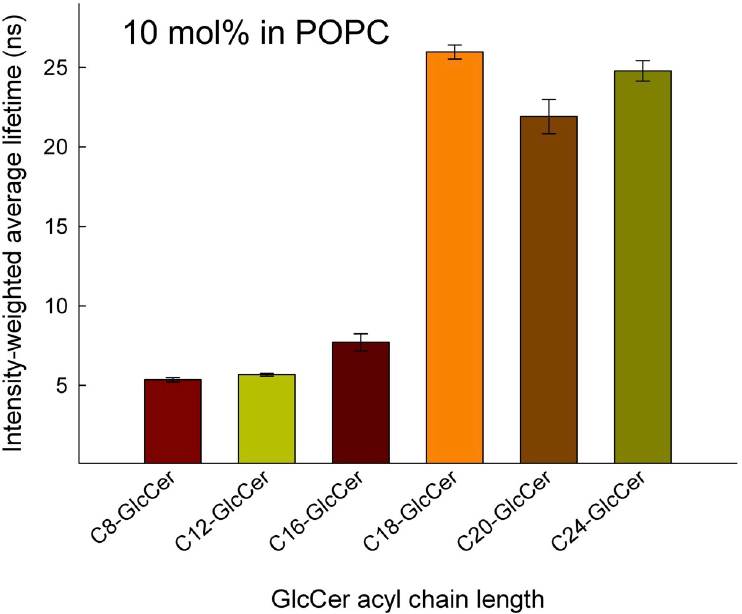
Fig 4. Intensity-weighted average lifetime analysis as a function of bilayer vesicle composition. POPC bilayer vesicles (50 μ M) contained 10 mol% fully saturated GlcCer of different N-linked acyl chain length and 1 mol % trans- parinaric acid. The trans-parinaric acid (TPA) lifetime is short in fluid membranes ( < 5 ns), intermediate in a liquid- ordered phases, and long (35 ns) in gel and solid membranes. Average lifetimes (ns) are shown for each composition, with average ± SD for at least three independent